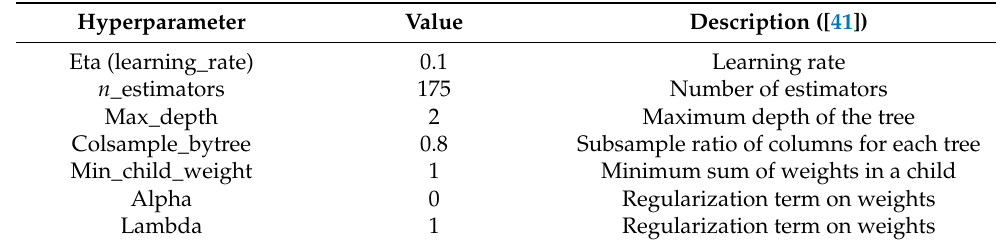
Table 3. Value of the main hyperparameters for the run of Figure 9d and their descriptions. Hyperparameter Value Description ([41]) Eta (learning_rate) 0.1 Learning rate n _estimators 175 Number of estimators Max_depth 2 Maximum depth of the tree Colsample_bytree 0.8 Subsample ratio of columns for each tree Min_child_weight 1 Minimum sum of weights in a child Alpha 0 Regularization term on weights Lambda 1 Regularization term on